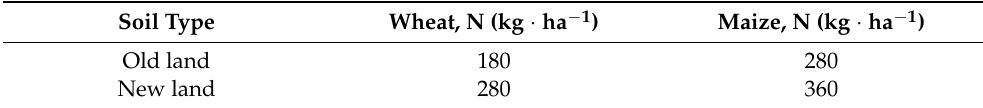
Table 2. Nitrogen fertilizer applications to the wheat and maize for old and new land in three agro-climate